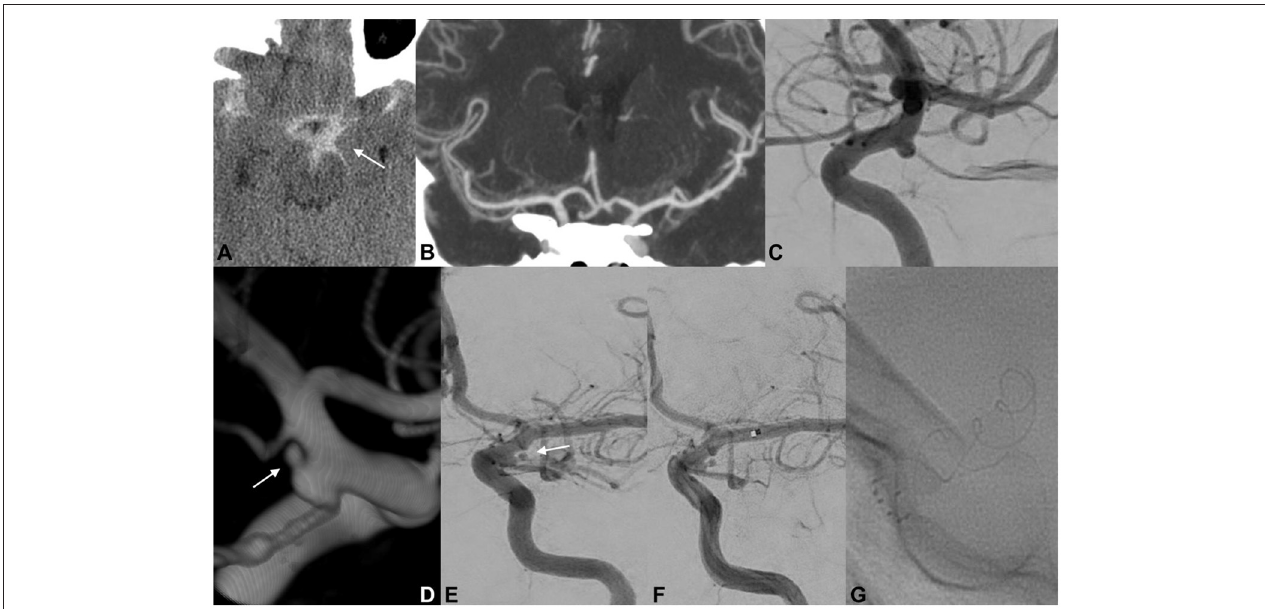
FIGURE 2 | EVT of a ruptured PcomA ID. An initial CT scan demonstrated the presence of SAH predominantly distributed across the left basal cisterns ( A ; white arrow). Cranial CTA did not document any cerebrovascular findings that could have caused the SAH (B) . At 6h after onset, catheter angiography confirmed the absence of a ruptured aneurysm but revealed a typical ID at the origin of the left PcomA (C) . Delayed 3DRA/DSA ( D,E ; white arrows) 7 days after onset identified a possible rupture bleb on the lateral side of the left PcomA ID. Endovascular coil embolization of the ruptured bleb was unsuccessful, and a p64 FD was carefully deployed across the C7 segment of the left ICA (F,G) . Contrast stagnation inside the ruptured ID bleb was seen on the delayed angiographic phase (not provided).